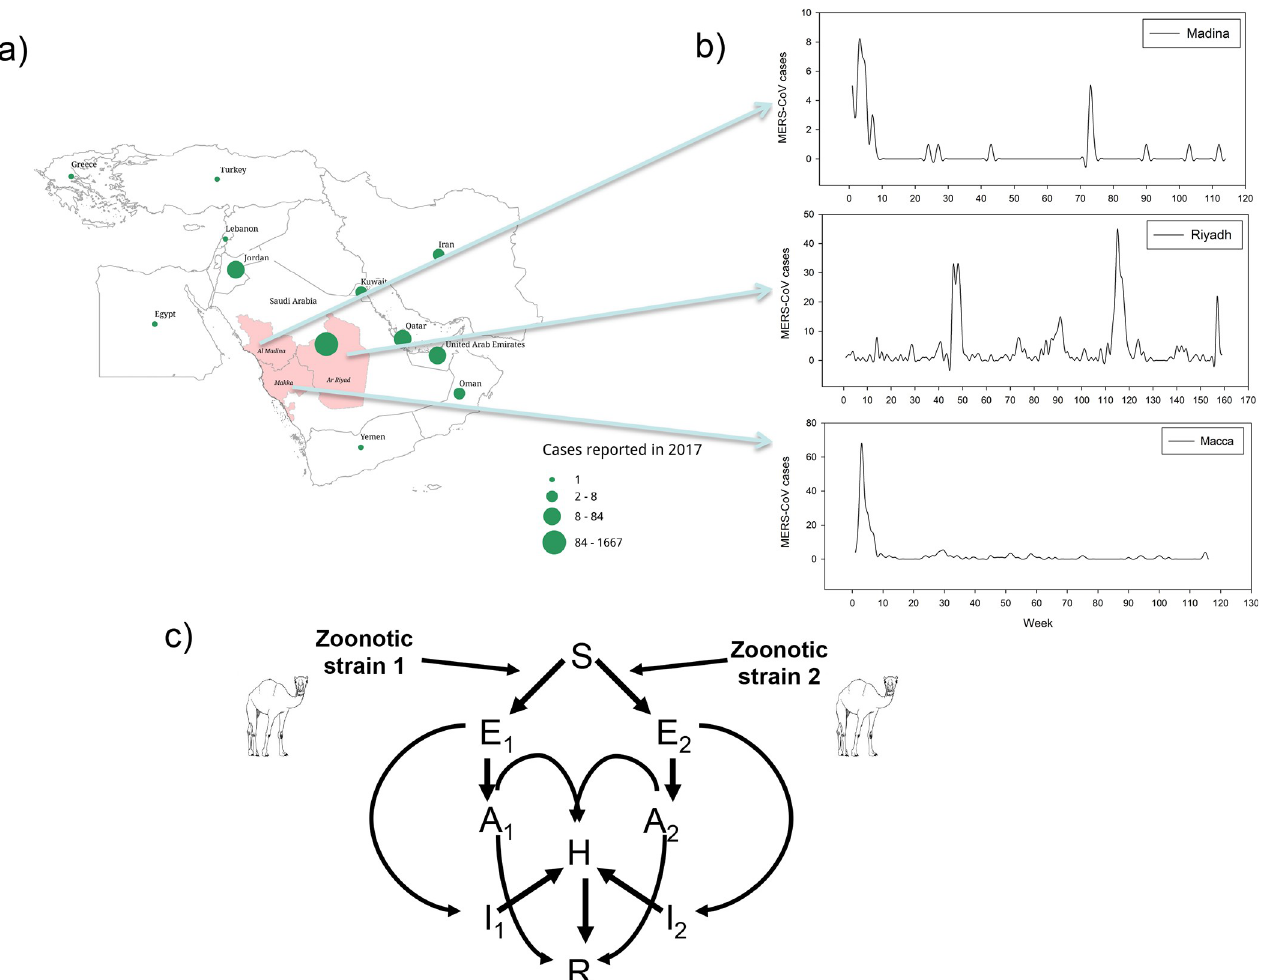
Fig 1. Distribution of MERS-CoV weekly cases in Riyadh, Macca and Madina provinces during July, 2013—June, 2016. (a) The geographic distribution of MERS-CoV cases reported in 2017 in the Middle East. (b) Time series of weekly incidence data of MERS-CoV in three major provinces, Riyadh, Maccaand Madina, respectively. (c) Two strain Models flow diagram considering asymptomatic, symptomatic, hospitalized, and Zoonotic transmission. Open source KML map for the Middle East was kindly obtained and redrawn by Josep-BoyardMicheau from https://community.qlik.com/t5/Qlik-Sense-Enterprise- Documents/GCC-Middle-East-country-boundary-KML-maps-KML-Shapefile/ta-p/1478595.